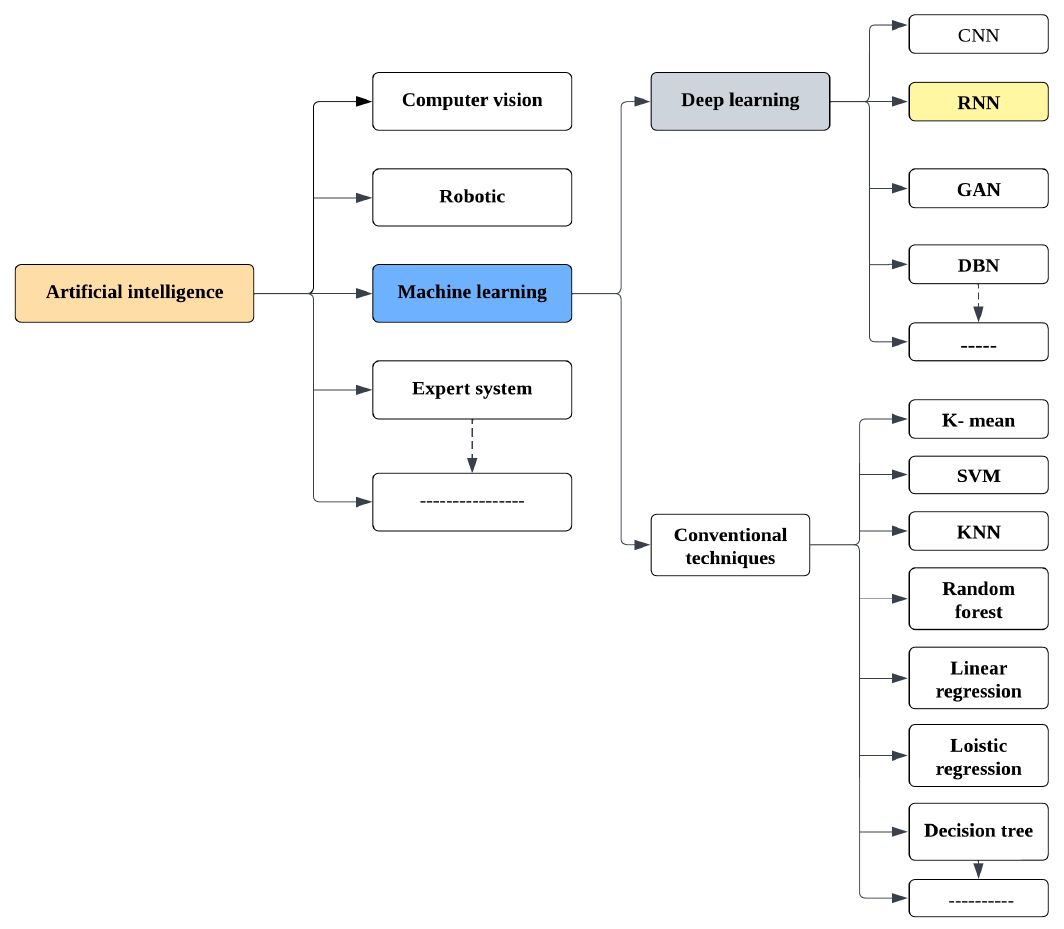
Figure 1. Flowchart illustrating AI techniques for virus detection and classification .